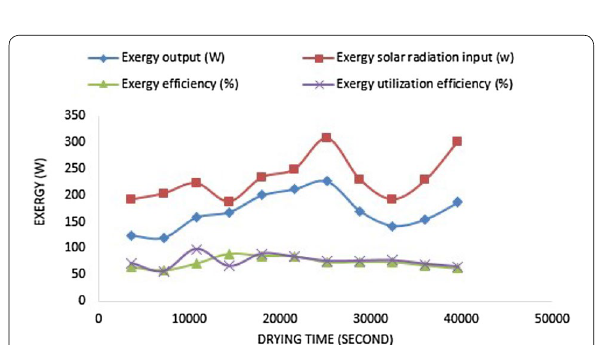
Fig. 23 Variation of efficiency as a function of drying time and exergy in the drying chamber (4th day)